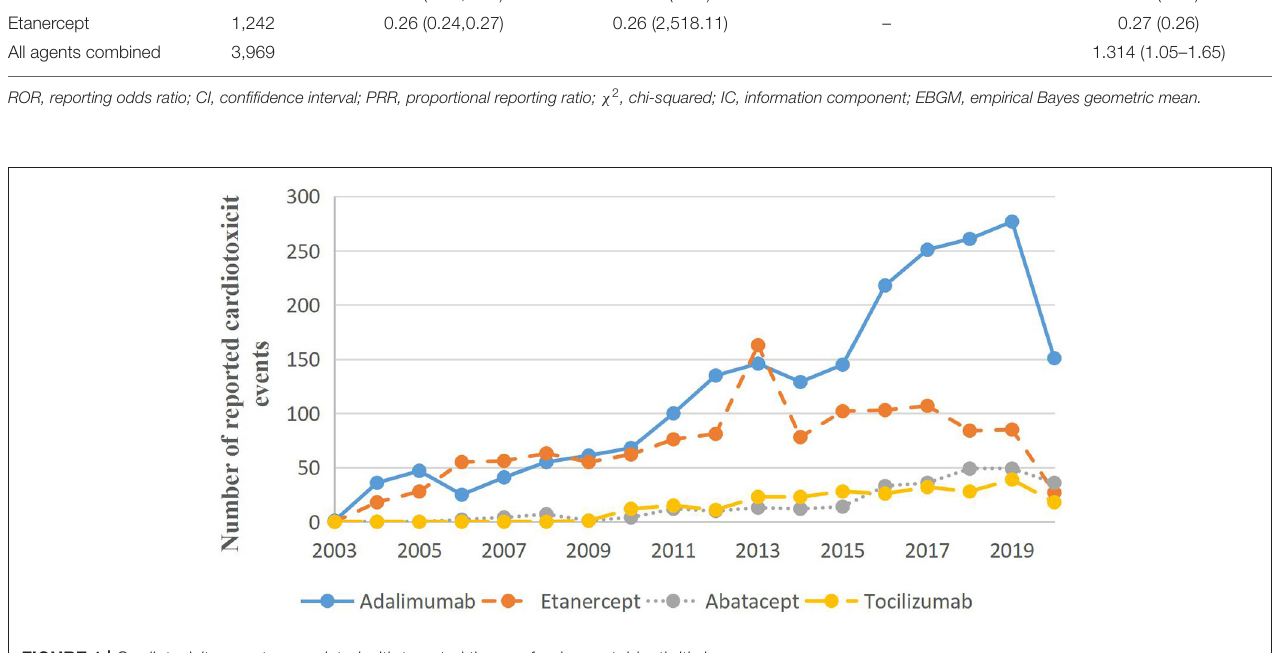
FIGURE 1 | Cardiotoxicity reports associated with targeted therapy for rheumatoid arthritis by year.